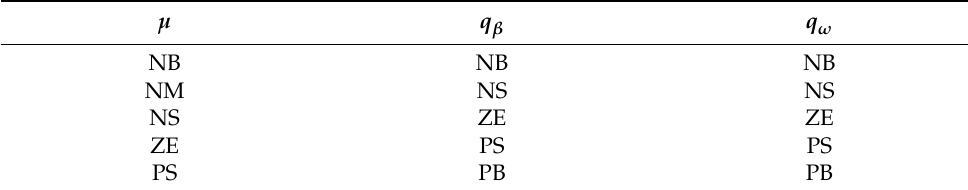
Figure 7. Membership function of μ .